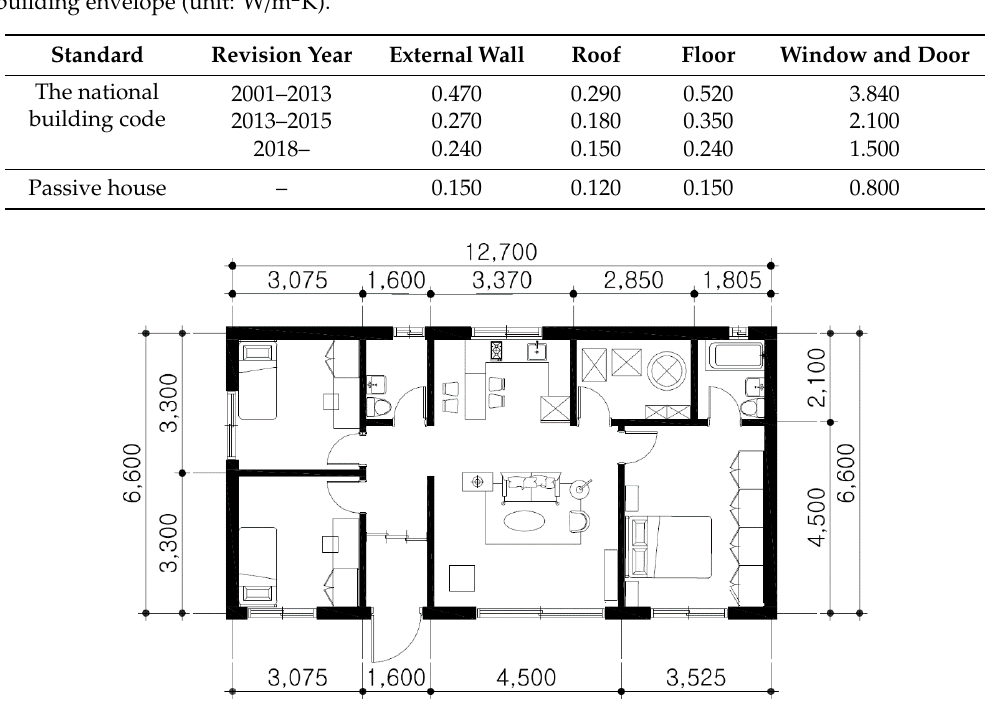
Table 1. Simulation building parameters.